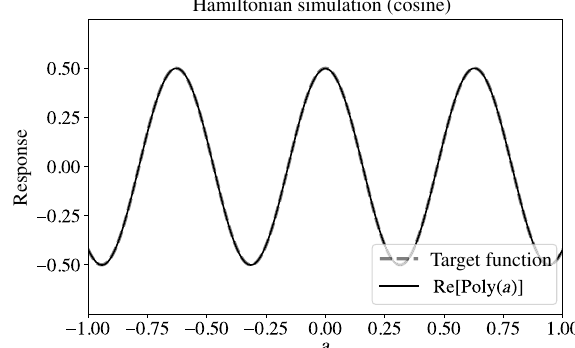
FIG. 22. The response function for the polynomial approxima- tion to the inverse function with κ = 3 and (cid:14) = 0.3.